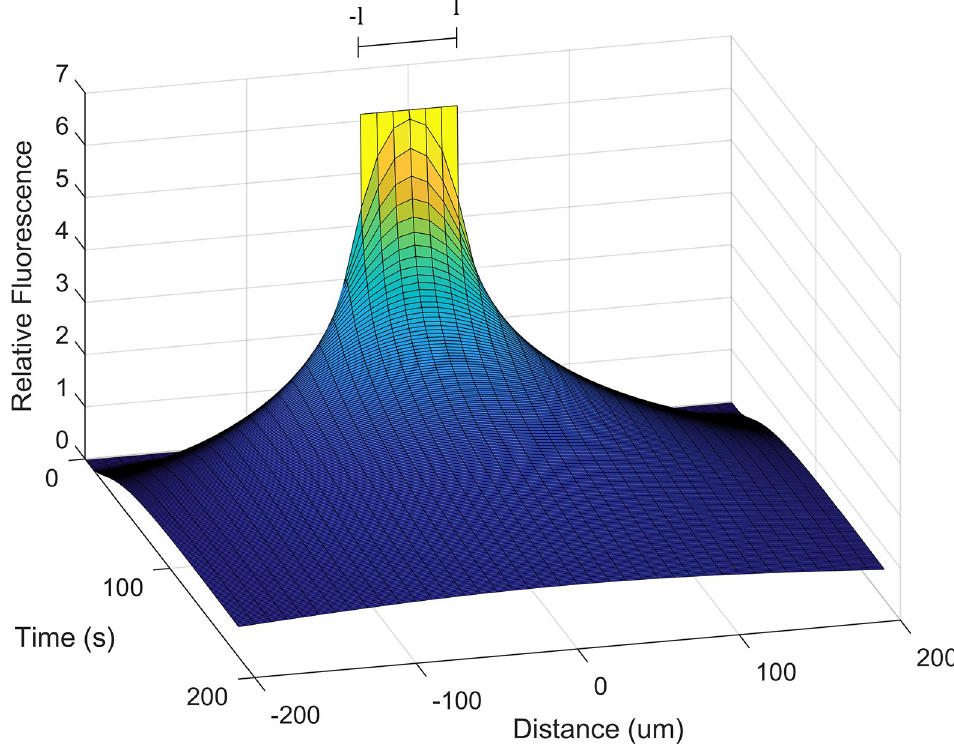
Fig 3. The diffusion of molecular tracer from the cut location, modelled according to Eq (9). At t = 0, all molecular tracer is located within the region– l < x < l surrounding the x-axis. Concentration of Neurobiotin TM is represented as relative fluorescent intensity along the